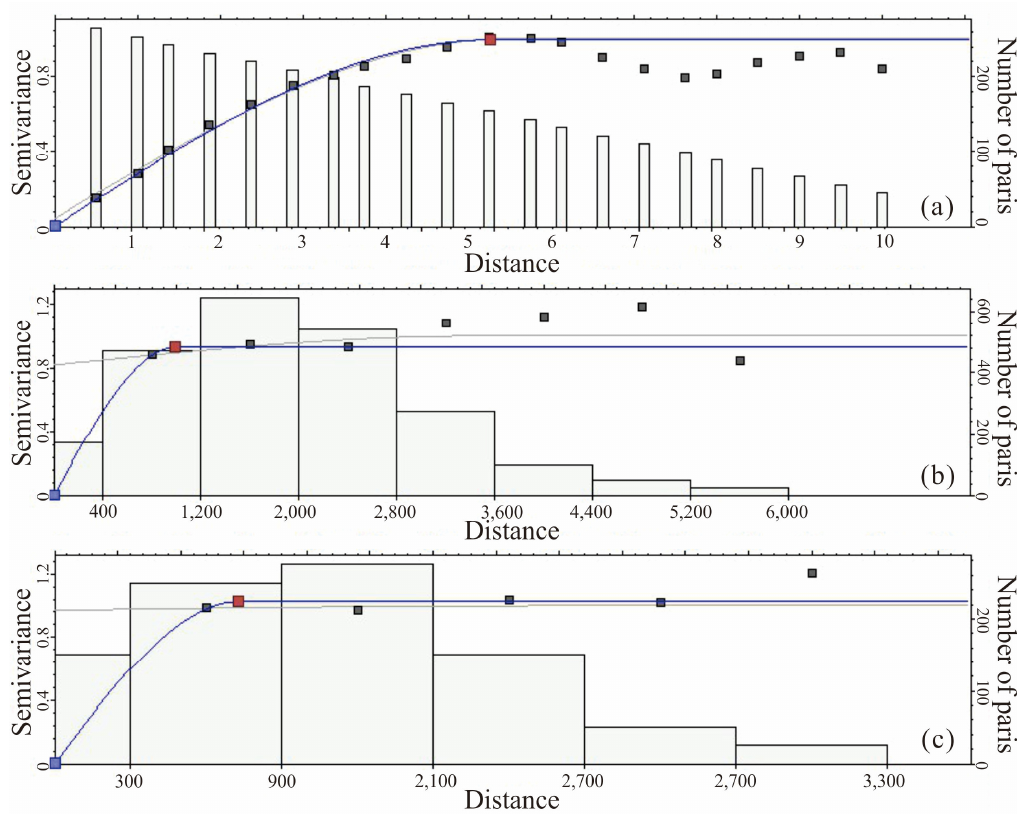
Figure 6. Scatter diagram of variation function of distributary channel microfacies in h 81 bed.